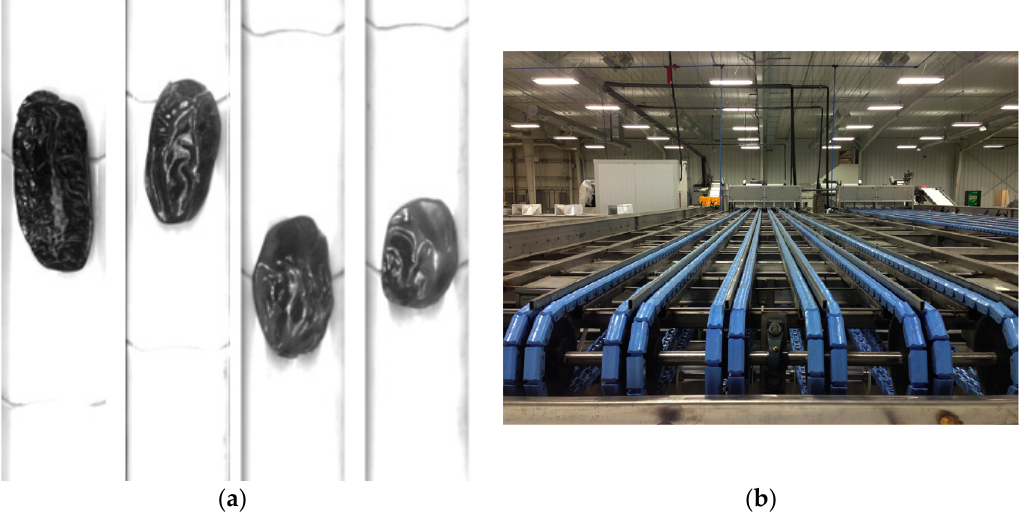
Figure 8. ( a ) Samples of four levels of skin delamination (from left to right: Large, Extra Fancy, Fancy, and Confection) and ( b ) sorting machine.